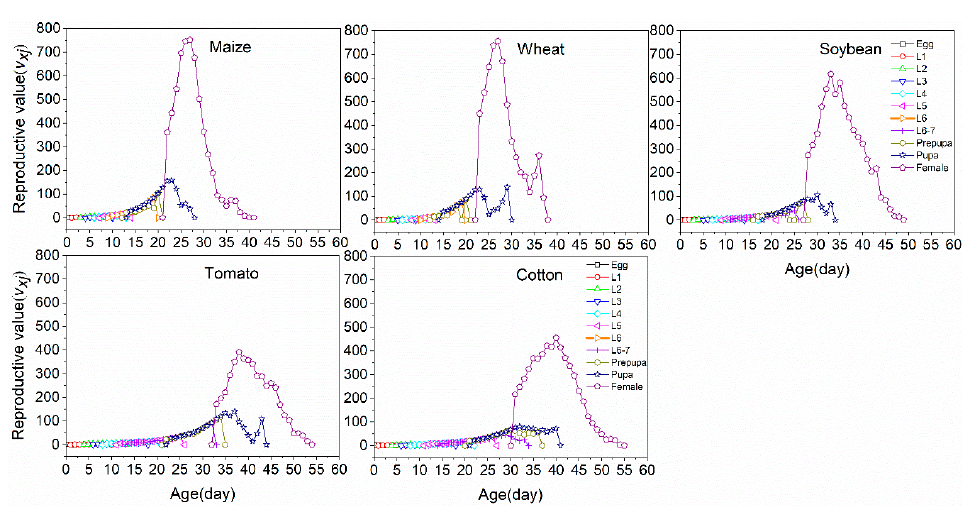
Figure 5. Age-stage specific reproductive value ( v xj ) of S. frugiperda fed on five host crops.